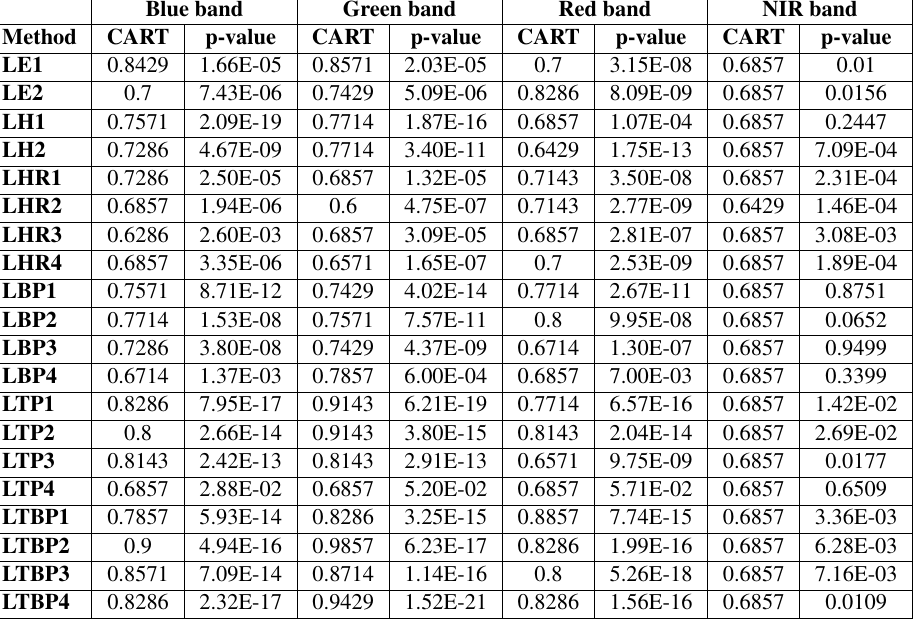
Table 1: Evaluation of texture analysis measures through t -tests and